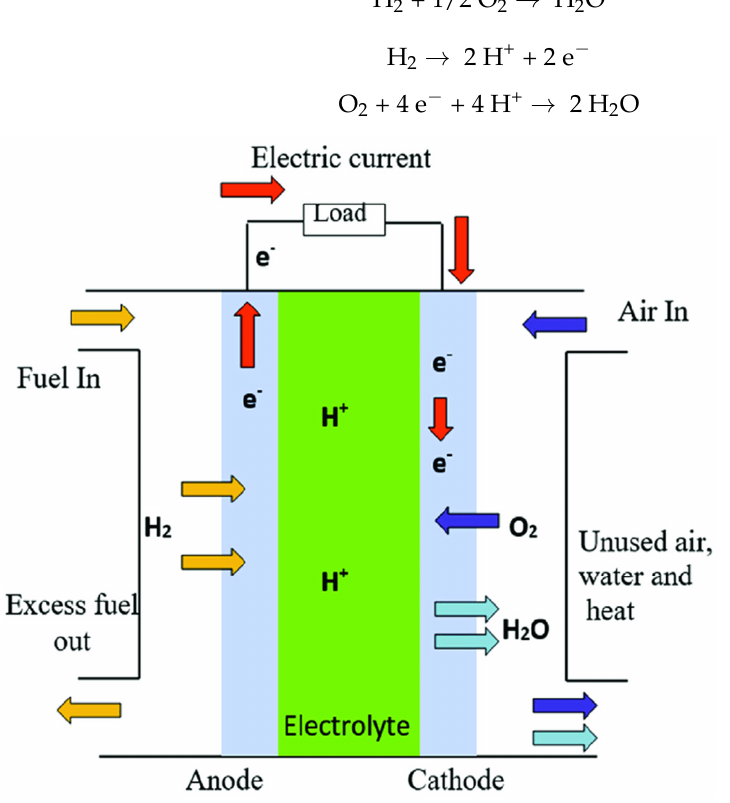
Figure 2. Schematic diagram for PEMFC [19].